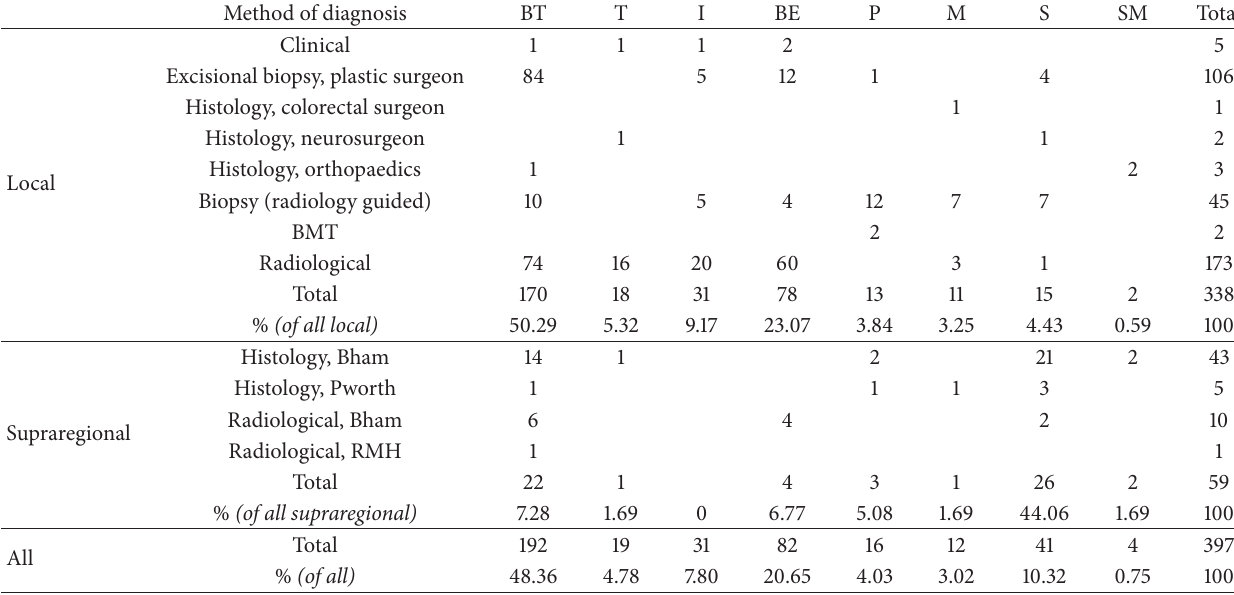
Table 1: Diagnostic pathways and